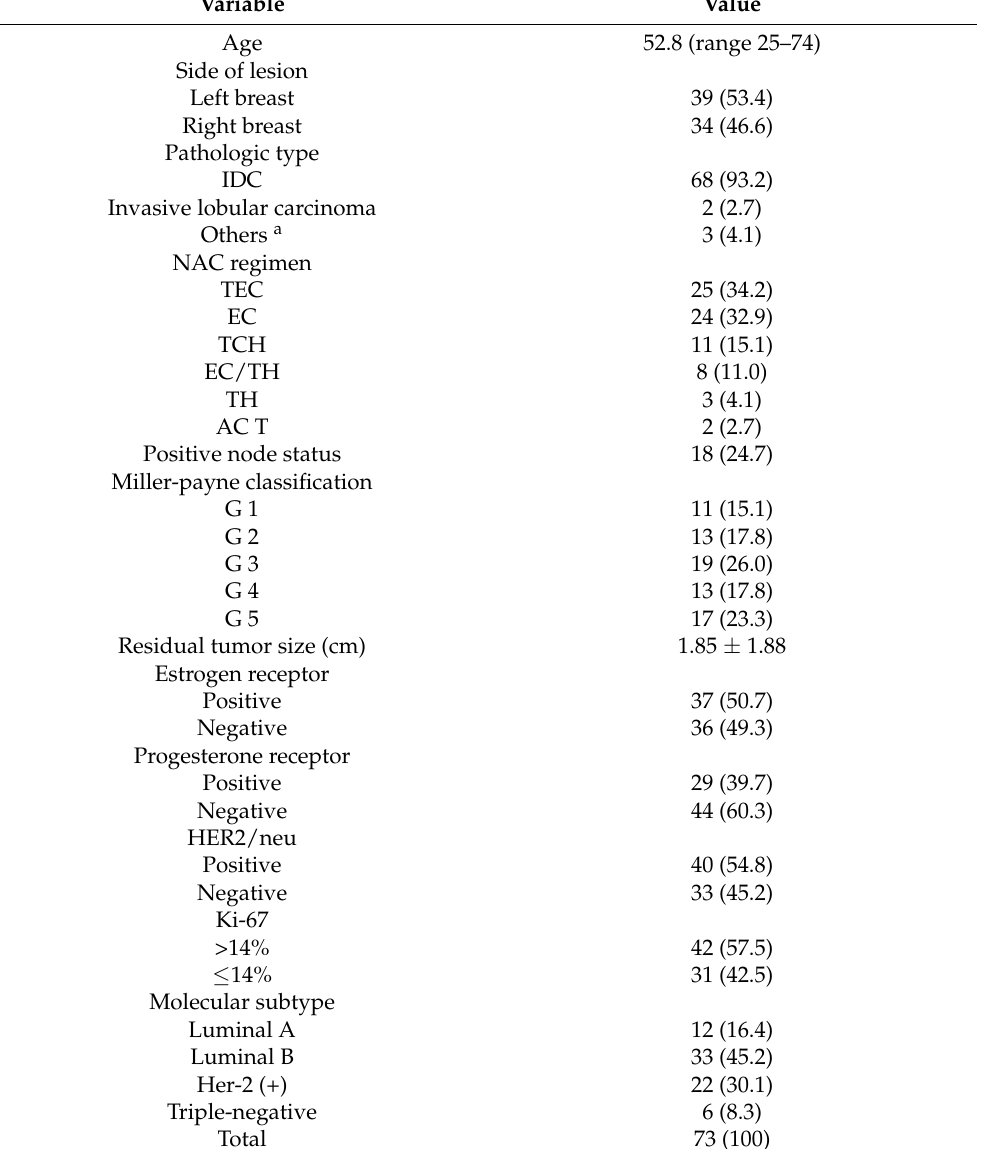
Table 1. Patient population